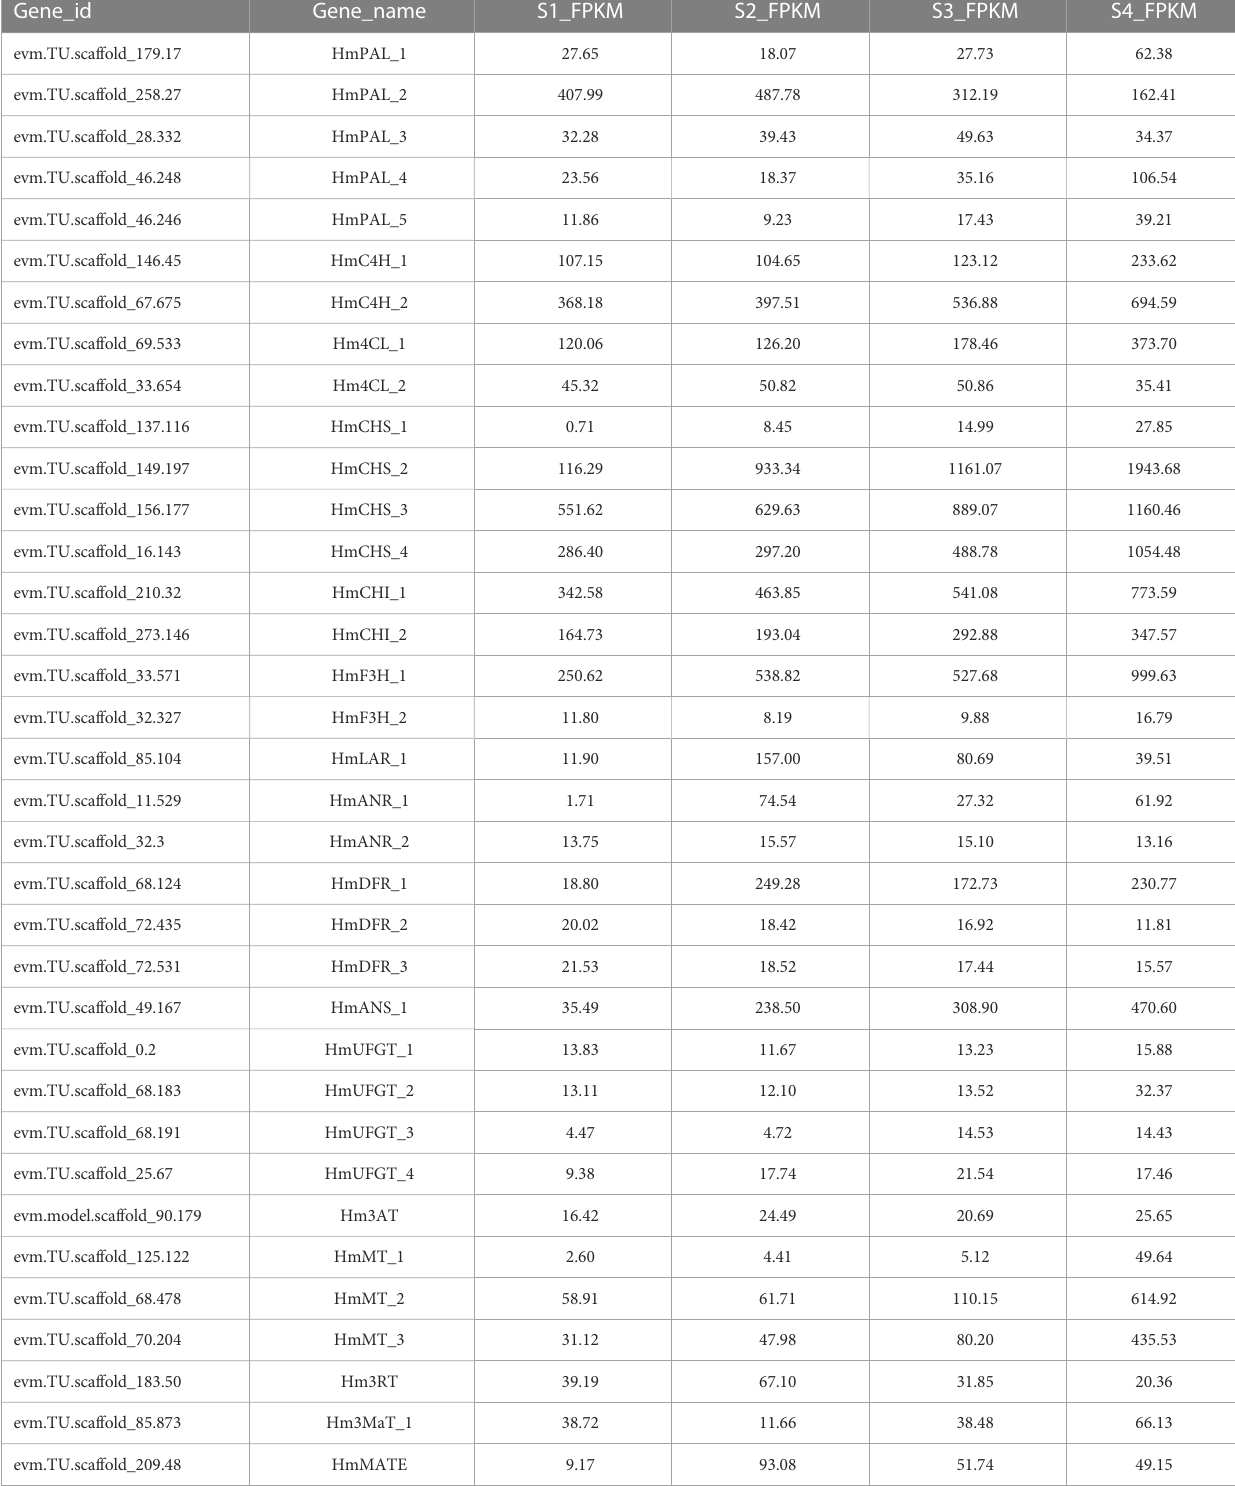
TABLE 1 Candidates in the anthocyanin structural genes of Heptacodium miconioides sepal.